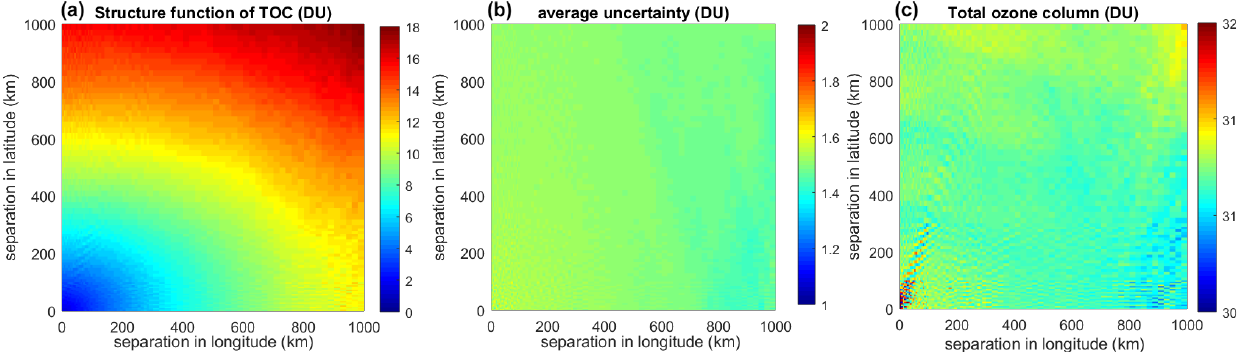
Figure 3. Illustration of structure function in July 2018 and other associated parameters, for latitude 30–60 ◦ N. (a) The structure function √ D( ρ ) (DU). (b) Mean uncertainty (DU) corresponding to the separations (pairs of points). (c) Mean ozone column (DU) expressed as corresponding to the